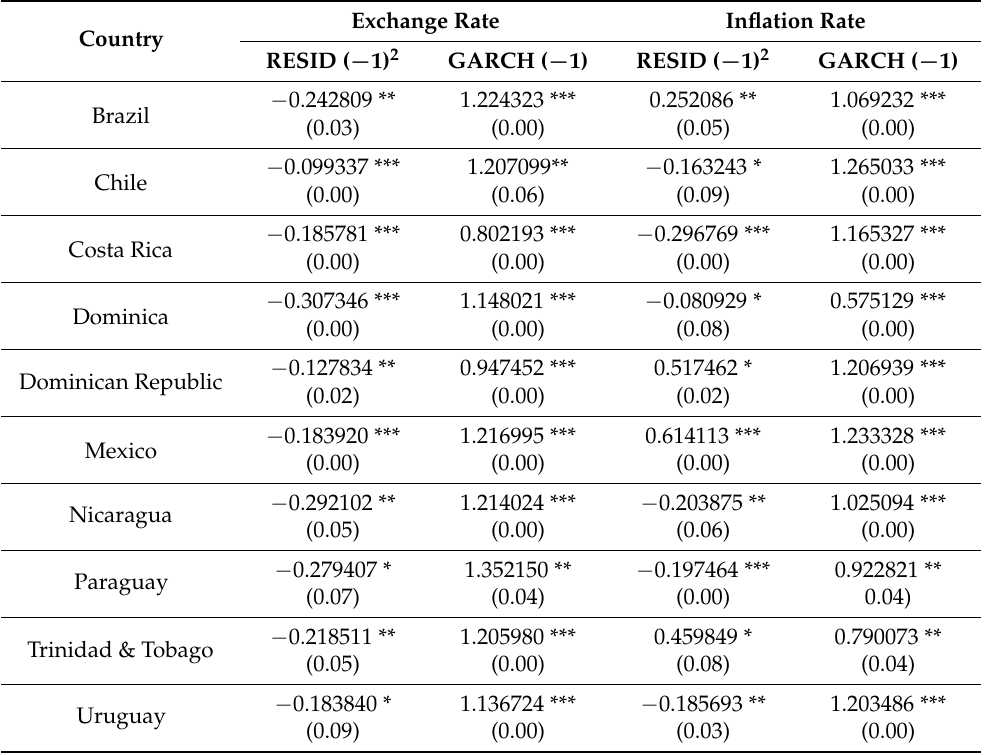
Table 6. GARCH (1,1) Estimation